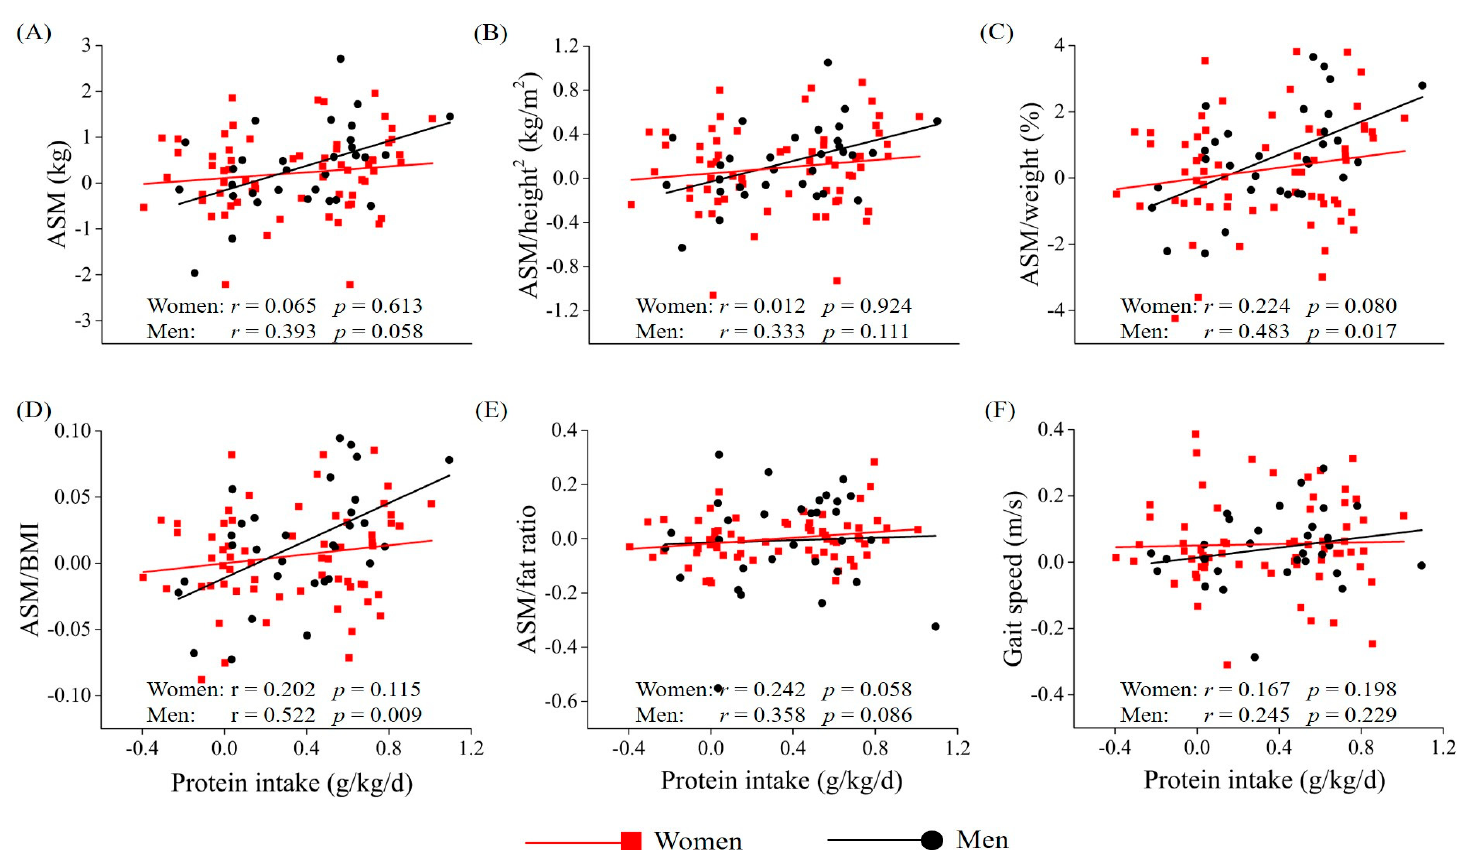
Figure 1. Partial correlation between changes in muscle mass ( A–E ) and gait speed ( F ) and change in protein intake (g/kg/day) in women and men. Red squares ( ■ ) represent data for women, and black circles ( • ) represent data for men. For partial correlation analysis to assess the relationship between muscle mass and protein intake, it was adjusted for cognitive impairment, baseline dietary intake of protein, and baseline muscle mass in women; age, alcohol drinking, cognitive impairment, frailty, activities of daily living disability, baseline dietary intake of protein, and baseline in men. For partial correlation analysis to assess the relationship between gait speed and protein intake, it was adjusted for living alone, activities of daily living disability, instrumental activities of daily living disability, and baseline gait speed in women; age, smoking, comorbidity, instrumental activities of daily living disability, and baseline gait speed in men. ASM, appendicular skeletal muscle mass; BW, body weight; BMI, body mass index.